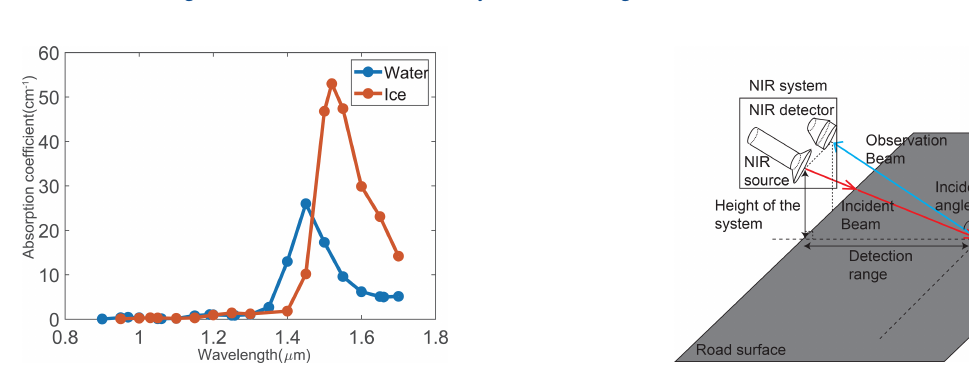
Figure 1. Absorption coefficient of ice and water according to Irvine and Pollack (1968).